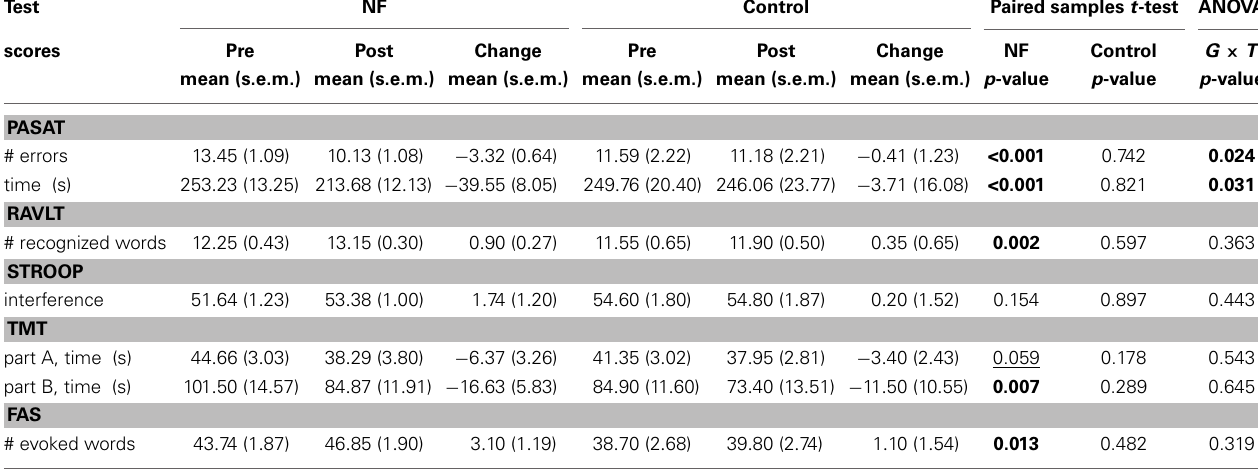
Table 2 | Cognitive performance at the beginning and at the end of the study for each group.